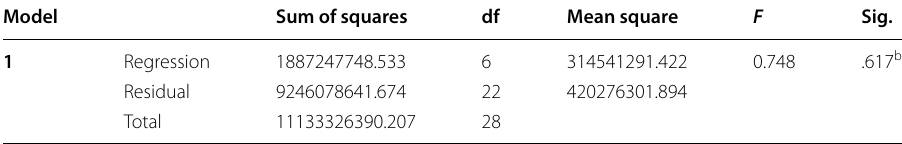
Table 11 Analysis of variance (ANOVA) for factor 3 variables Model